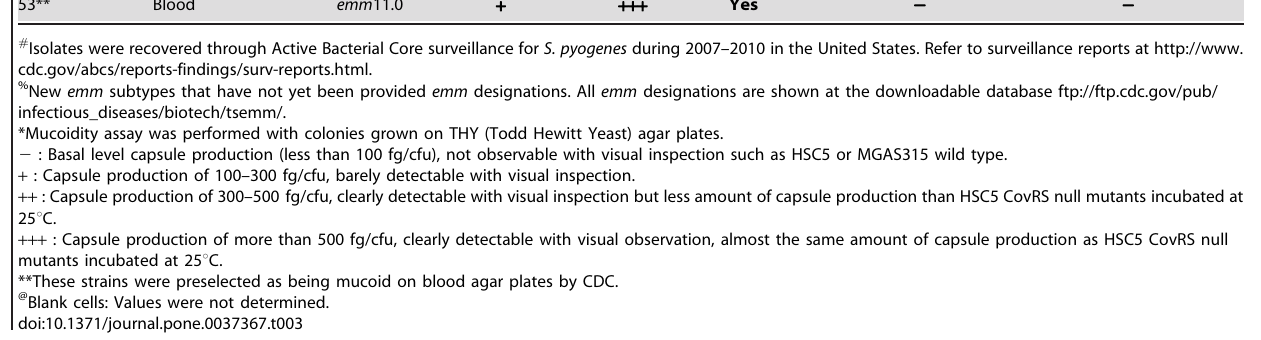
transposon insertion within the hasABC operon, confirming that transcription from the transposon occurs. The covR in-frame deletion strain, CovRIFD, was used as the capsule-thermoregu- lated background strain for the transposon mutagenesis. Among transposon-generated mutants, eight strains produced no capsule transposon insertion site revealed that each of these strains that lacked capsule production at either temperature contained a Table 4. Alterations in the covRS sequence of strains exhibiting capsule thermoregulation. #